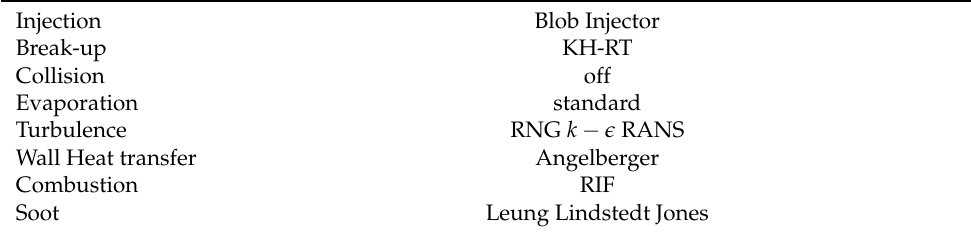
Table 2. CFD models specifications.